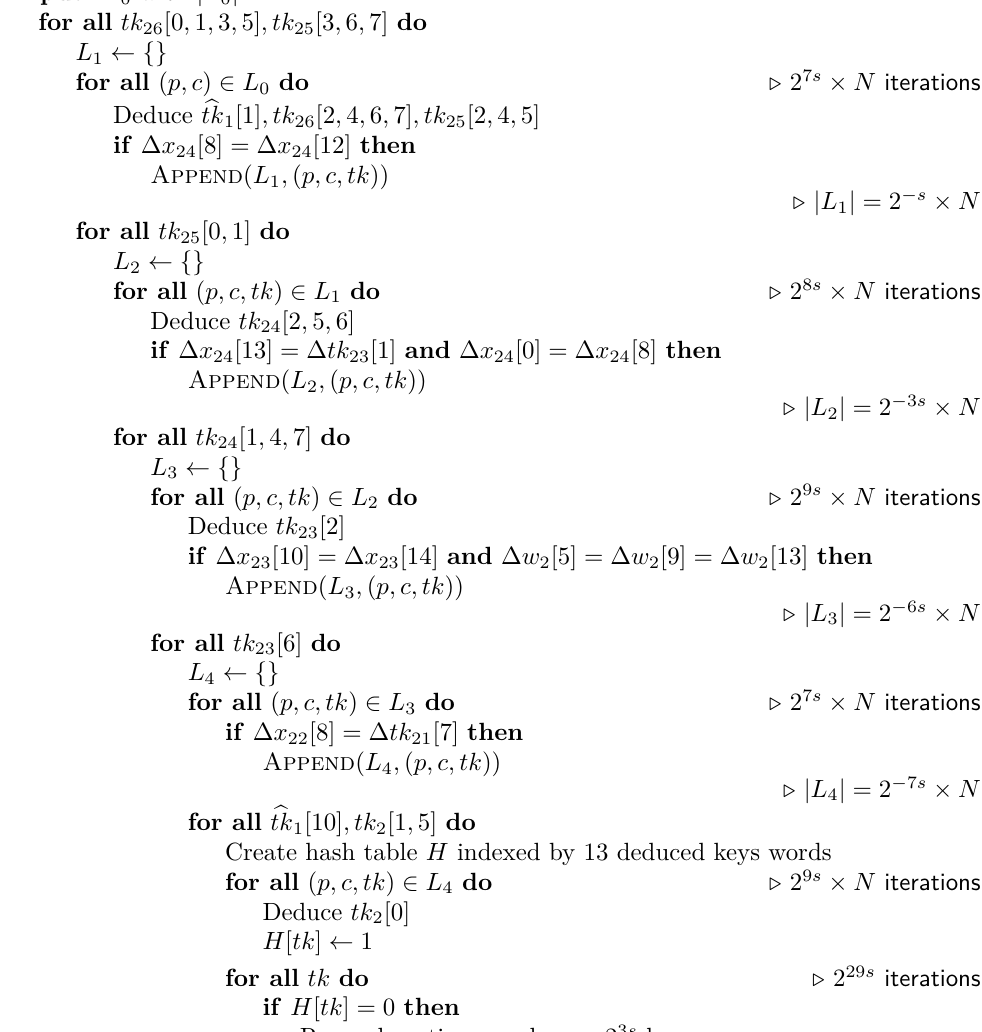
Algorithm 1 Implementation of this attack with early abort and low memory. tk represents the accumulated knowledge about the